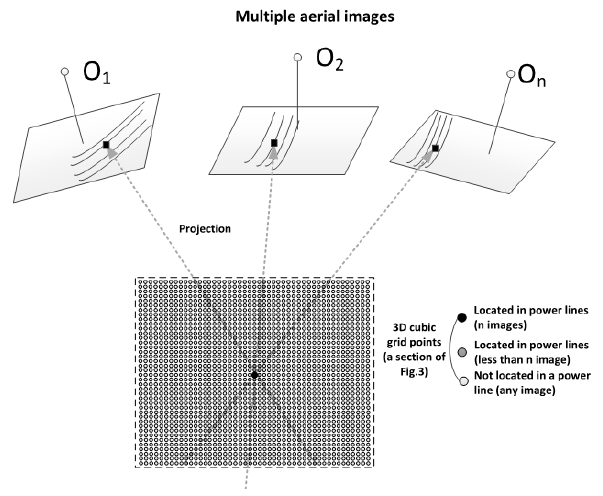
Figure 4. Projection of cubic grid points (3D) into multiple images (2D) for power line point selection.